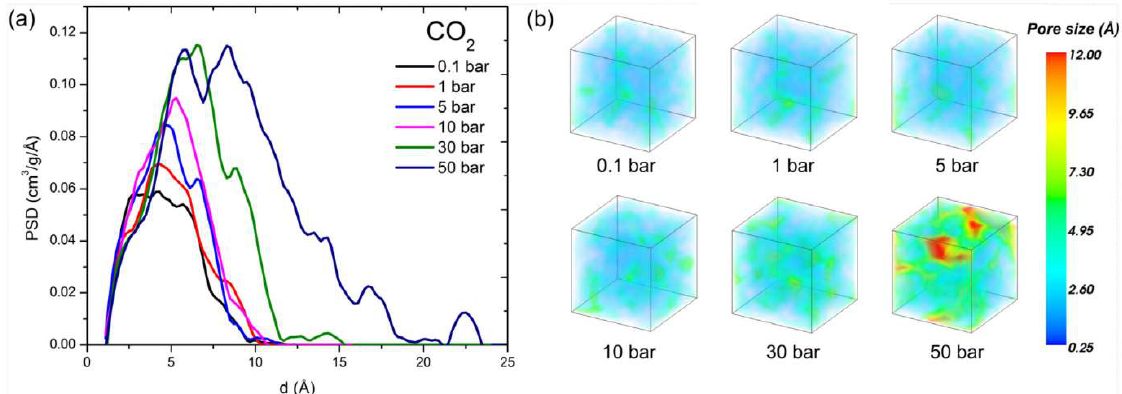
Figure 23. Simulated ( a ) pore-size distribution of PIM-1 and ( b ) 3D pore-size visualization as a function of CO 2 uptake from molecular simulations. Reproduced with permission from [382]. Copyright 2018, Elsevier.